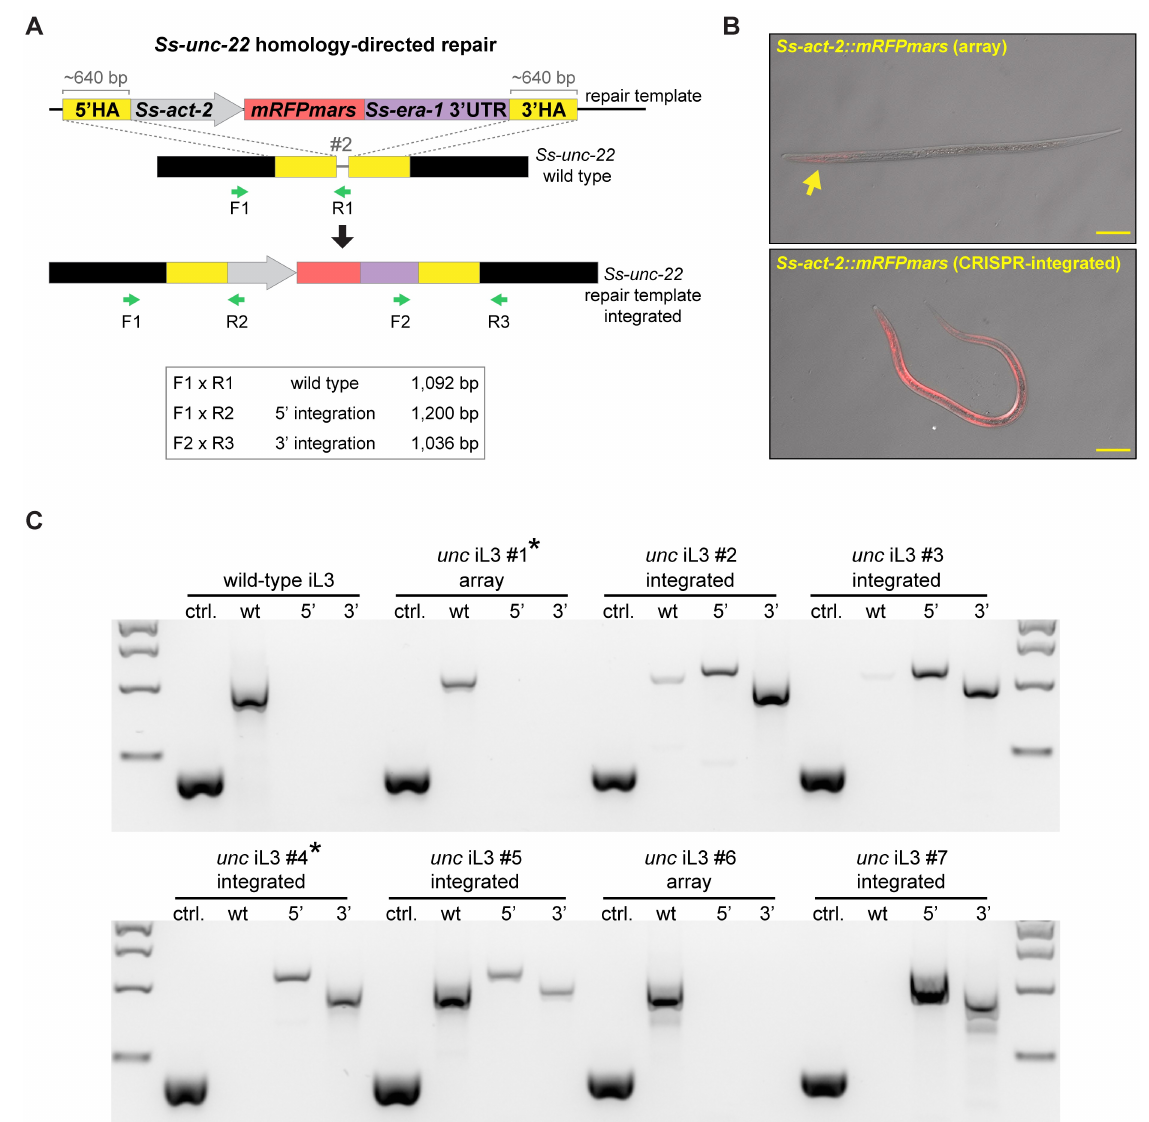
Fig 5. CRISPR-mediated homology-directed repair of Ss-unc-22 . ( A ) Strategy for HDR at Ss-unc-22 target site #2. unc F 1 iL3s that displayedboth the nicotine-twitchingphenotypeand red fluorescence were selectedas candidates for HDR and were genotyped using the primer sets indicated.5’ and 3’ integrationprimer pairs amplify only followingsuccessful integrationof Ss-act- 2 :: mRFPmars into site #2. HA = homologyarm. ( B ) Representative DIC + epifluorescence overlays of unc F 1 iL3s expressing Ss- act-2 :: mRFPmars . Top, iL3 expressing mRFPmars (sparse expressionindicatedby the arrow) from an extrachromosomal array. Bottom, iL3 expressing mRFPmars followingHDR, showingnear-uniform mRFPmars expressionin the body wall. For both images, anterior is to the left. Scale bar = 50 μ m. ( C ) Representative genotypesof a wild-typeiL3 and unc F 1 iL3s expressing mRFPmars . Genomic DNA from individualiL3s was split into four reactions: ctrl. = control reactionamplifying416 bp of the first exon of the Ss-act-2 gene to confirm the presenceof genomicDNA; wt = reactionfor the wild-typelocus of site #2 where primer R1 overlaps the predicted CRISPR cut site; 5’ = reactionfor insertionof the 5’ border of the integrated cassette; 3’ = reaction for insertion of the 3’ border of the integratedcassette. For genotypes: array = red unc F 1 iL3s that showedno evidenceof integration; integrated = red unc F 1 iL3s with successful HDR. Some integratediL3s had putative homozygous disruptionsof Ss-unc-22 site #2 ( e . g .iL3s #4 and #7, which lacked the wt band). Asterisks indicategenotypes for iL3s shown in B . Size markers = 2 kb, 1.5 kb, 1 kb, and 500 bp from top to bottom.